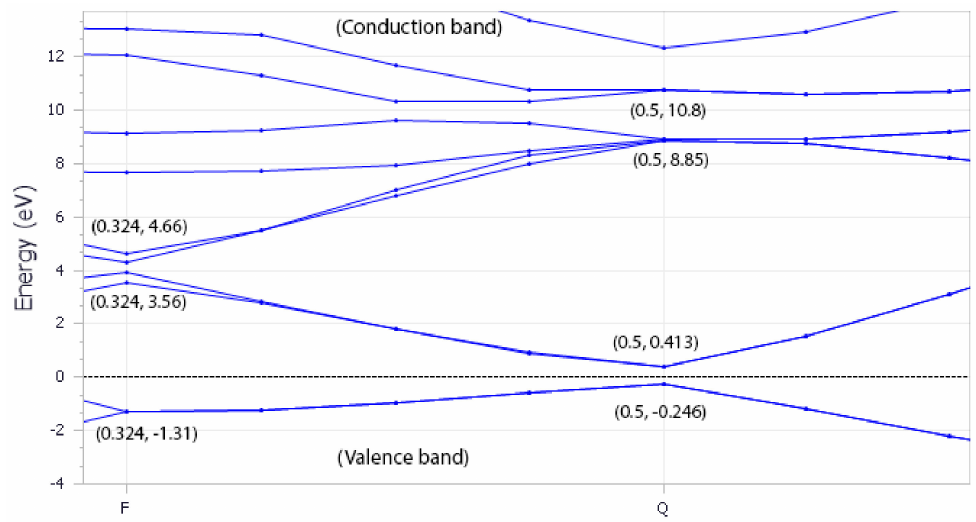
Figure 5. Band structure at range F (0.324) and Q (0.5)